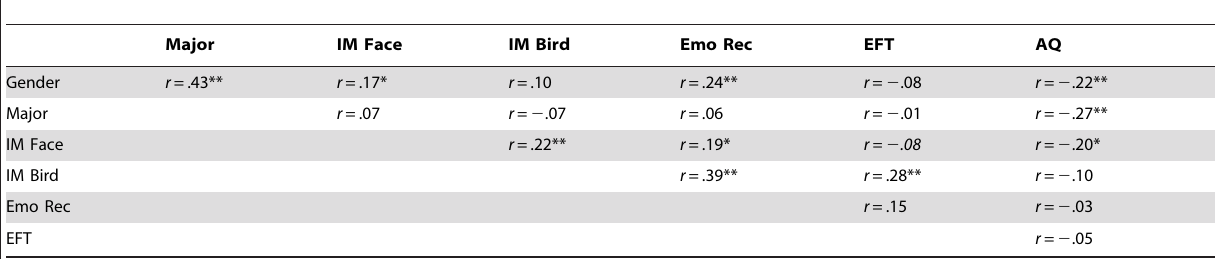
Table 2. Correlations between all